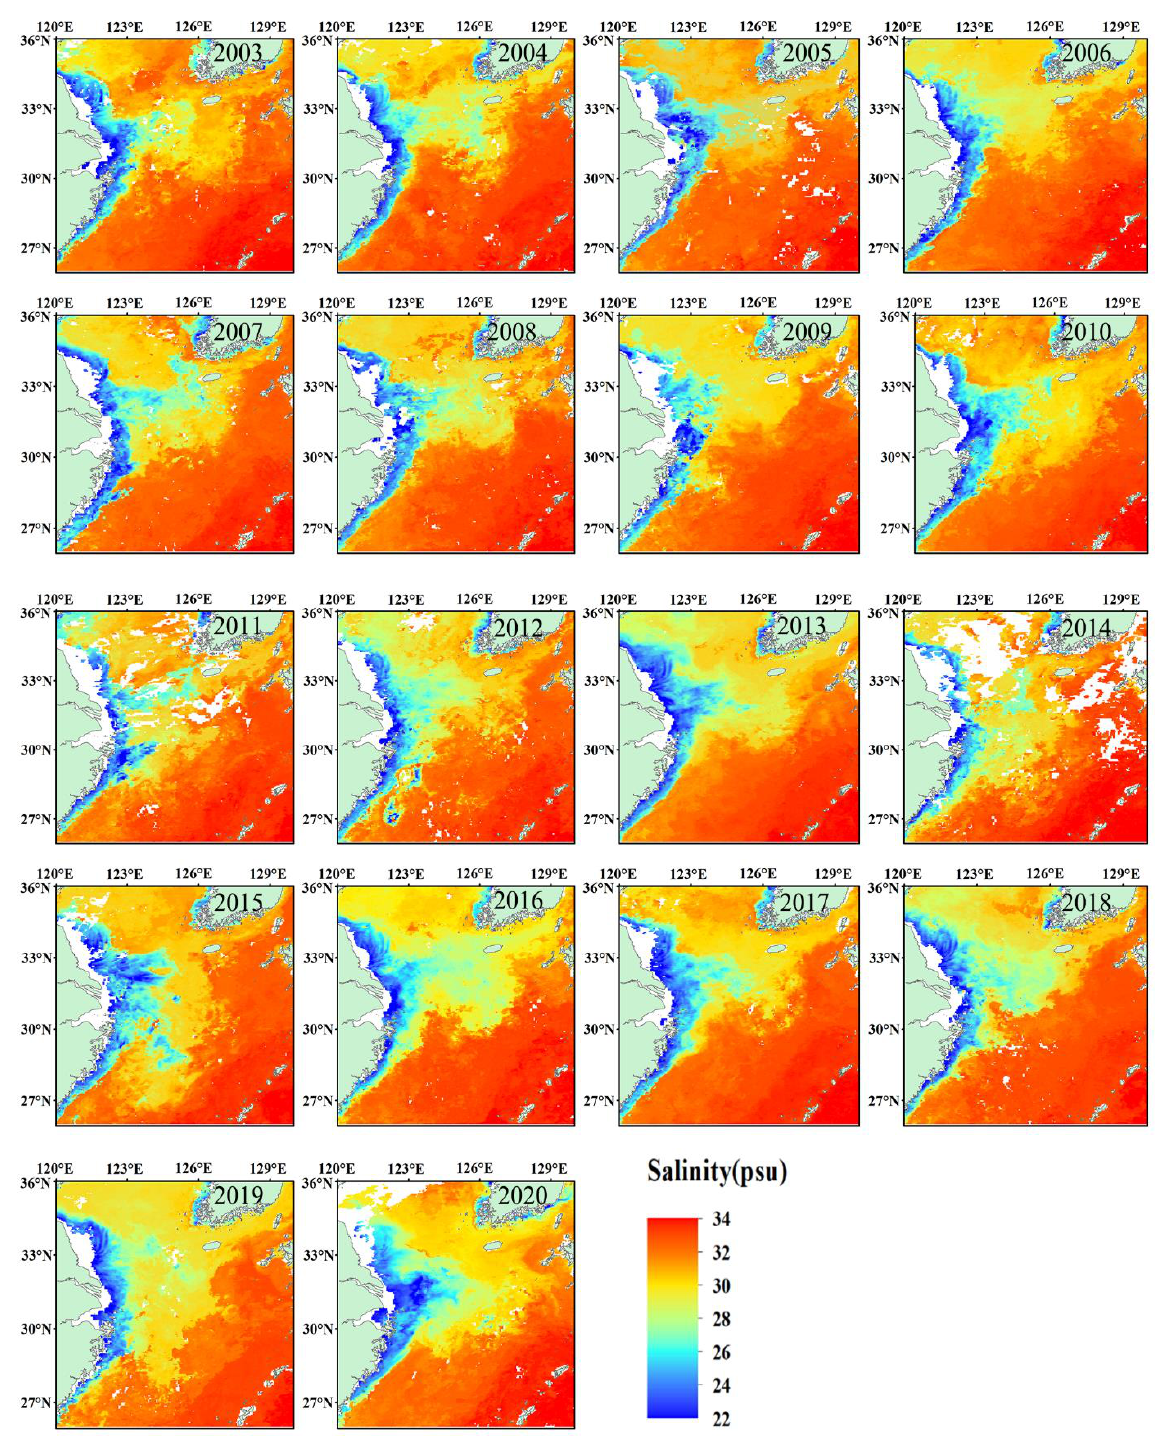
Figure A1. SSS inversion results for August 2003 – 2020.